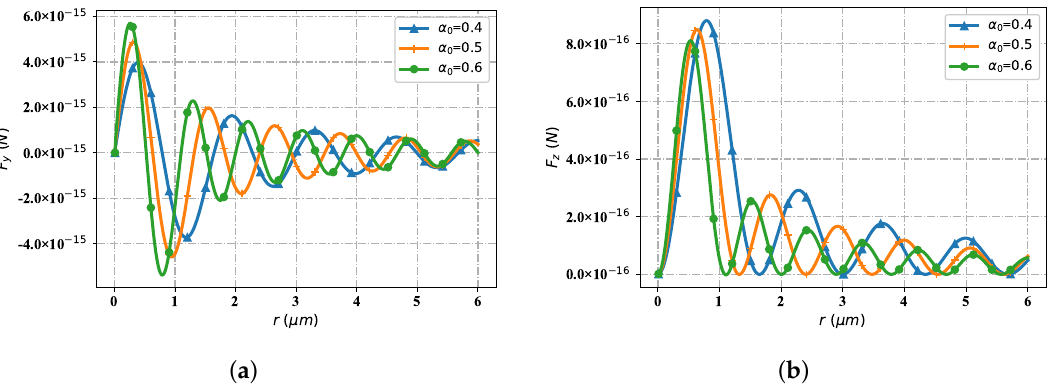
Figure 15. The influence of beam scaling parameter α 0 for optical force component F y and F z . ( a ) F y with different α 0 ; ( b ) F z with different α 0 . Figure 16 represents the spatial distribution of the optical radiation force compo- nent when the Bessel pincer light sheets beam interacts with particles as the beam order changes (particle radius is 0.1 µ m, beam scaling parameter α 0 = 0.5, incident wave length is λ = 1.064 µ m, beam order l is 10, 15 and 25). When the spatial position is r = 25 µ m, the distribution of radiation force component tends to converge. Figure 16a shows the distribution of the radiation force component F y with the change of spatial position with different beam orders. The wave crest of F y curve with beam order of l = 10 first reaches the first peak near the wave source; The next step is the F y curve with the beam order of l = 15. Relative to the curve with beam order of l = 10, the peak position is reached at the second place with a smaller peak but far from the wave source. When the F y curve with beam order of l = 10 and l = 15 alternately reaches its corresponding peak, the curve with beam order of l = 25 reaches its first peak position (the second peak position of the F y curve with the relative to beam order of l = 15) for the first time. Then, the F y curves corresponding to the three beam orders interlace with each other in turn and reach the subsequent peak positions respectively. In general, for the F y curve with beam order l = 10, the value of F y corresponding to the wave crest is higher than that of the F y curve with beam order l = 15, and the value of F y curve with beam order l = 25 is the lowest among the three. On the contrary, in the trough period, the value of F y curve with beam order of l = 25 is the highest among the three, followed by F y curve with beam order of l = 15, and finally by F y curve with beam order of l = 10. Figure 16b shows the radiation force component F z , which changes with the spatial location distribution under the influence of beam order. With the staggered distribution of wave crests, the F z components are numerically greater than or equal to zero. When the F z curve of beam order l = 10 first reaches the first wave peak at a position close to the wave source with a large value; The F z curve with the beam order l = 15 reaches the first wave peak with a smaller value at the position far from the wave source. When the F z curve with the beam order l = 15 reaches the third peak, the F z curve with beam order l = 25 starts to reach its first peak (numerically smaller than the first peak of the F z curve with beam order l = 15). Then, the peak value of each order successively reaches the corresponding peak until